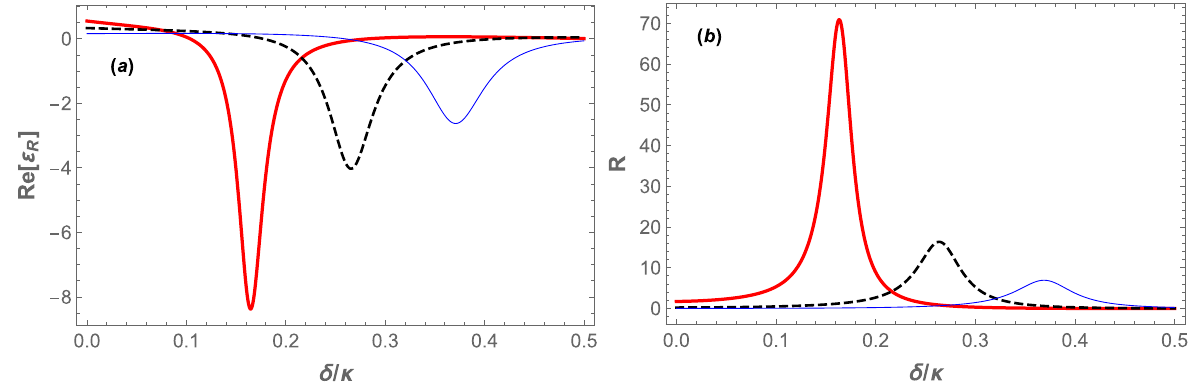
Figure 4. (Color online) ( a ) The real part of the reflected field amplitude. ( b ) The cavity power reflection coefficient at the signal frequency, versus the normalized frequency detuning ( δ/κ ), for the coupling laser pumping rate at | ε c | = 0.10 κ and three different values of ω sw , in the red detuning regime where � = ω B . The red thick, black dashed, and blue thin plots correspond to the values of ω sw = 5 ω R , ω sw = 10 ω R and ω sw = 15 ω R , respectively. The other parameters are the same as those of Fig. 2.